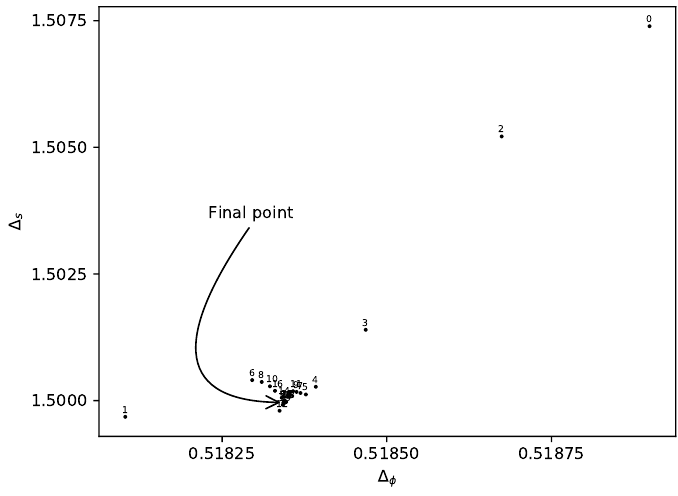
) projection of the “Constrained BFGS” run for the mini- Figure 12: ( ∆ φ , ∆ s mization of ∆ φ at Λ = 19. The run terminates on the tip of the arrow at = ( 0.518344,1.49996,1.23104 ) . The “Constrained BFGS” algorithm allows for x f the probing of disallowed points in its search for extremal allowed values; e.g. point 1 here has a navigator of